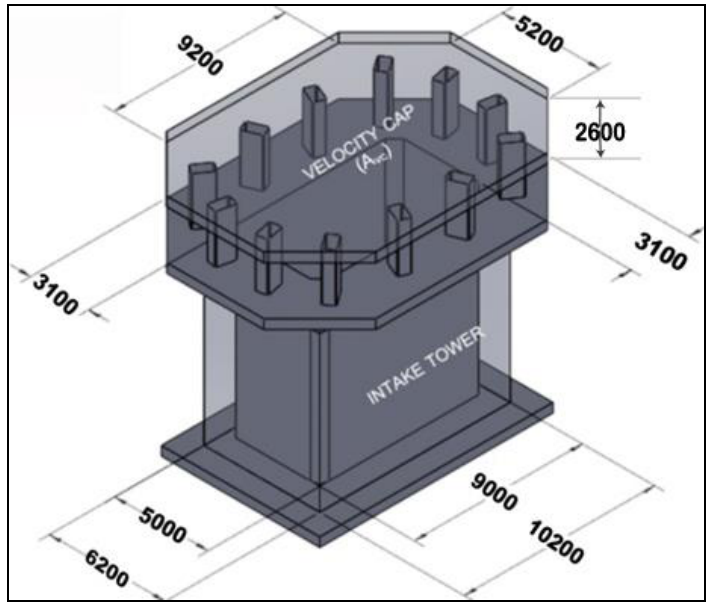
Figure 3. The overall dimensions (in unit mm) of the intake model.